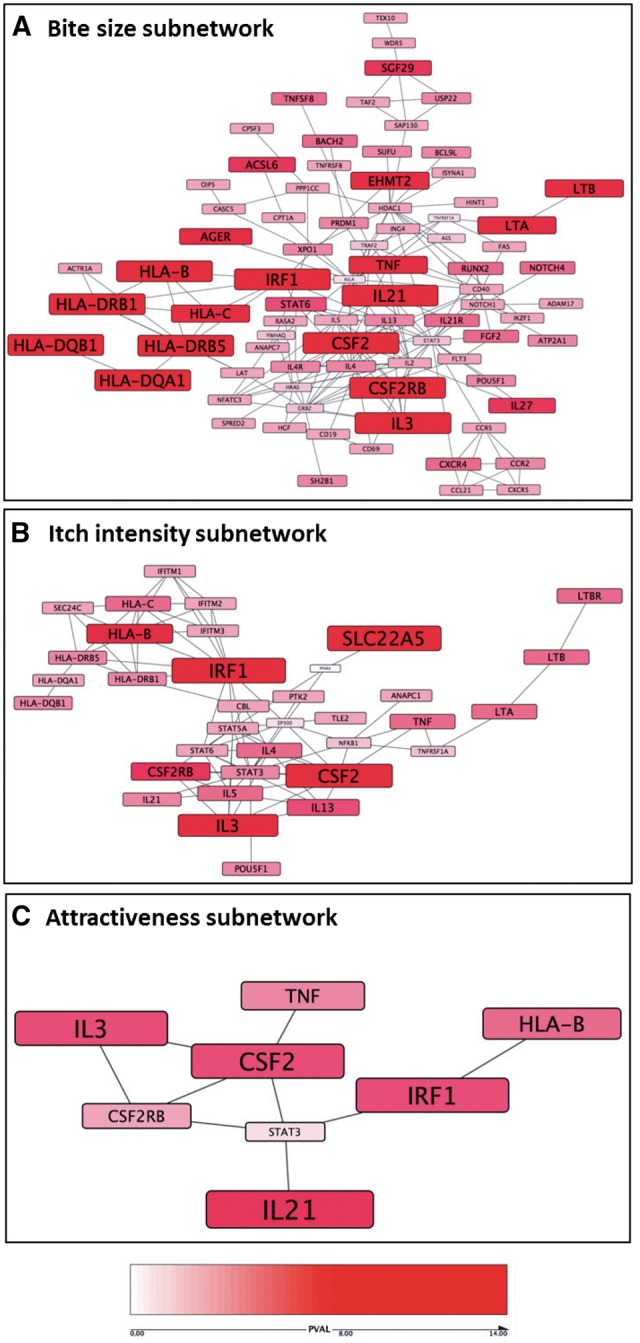
Mosquito-trait pathway analysis. The highest scoring PPI subnetworks based on the PASCAL gene-trait association scores are illustrated for the bite size (A), itch intensity (B) and attractiveness (C) GWAS; nodes are sized and coloured according to P value (red = Gene-trait association P > 1 × 10−8, white = Gene-trait association P = 0).